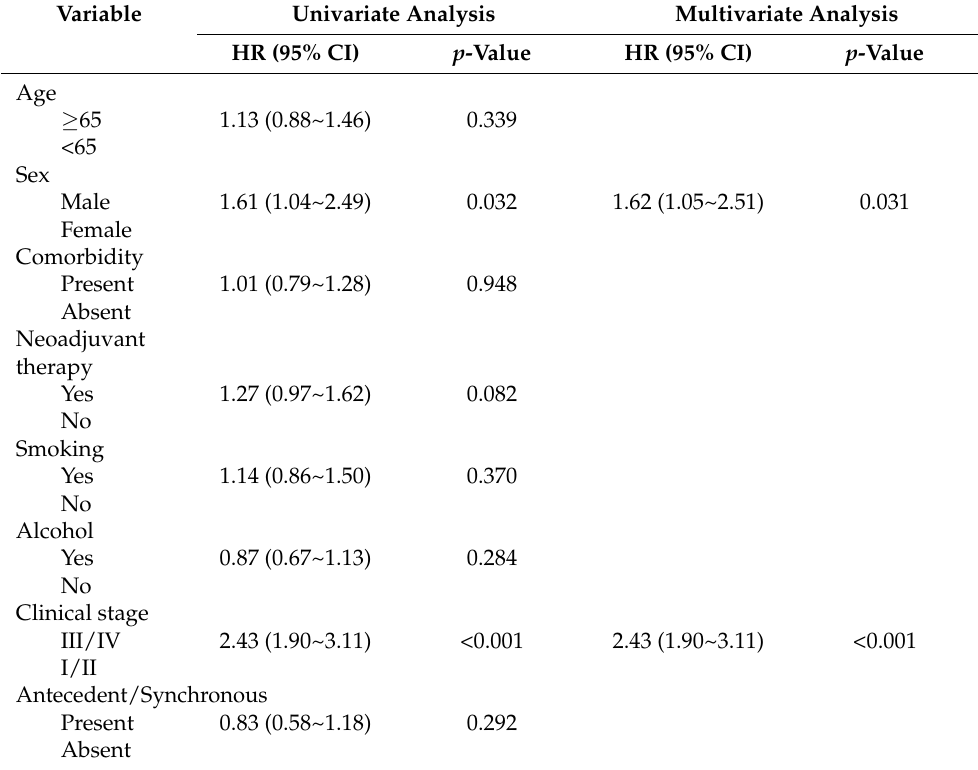
Table 2. Predictors of overall survival in Cox regression hazards model.